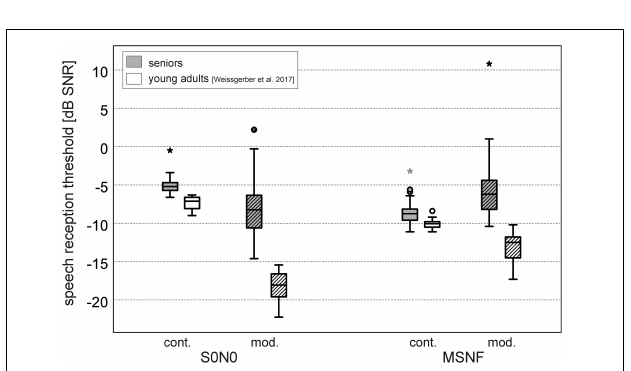
0.288 Correlation coefficients after partialling out high-frequency hearing loss PTA_high (second column). Gray values indicate non-significant correlations (p > 0.05). Values in black indicate significant results (p ≤ 0.05). Values in boldface indicate significant results after applying a Bonferroni-Holm correction. N/A: correlation non-